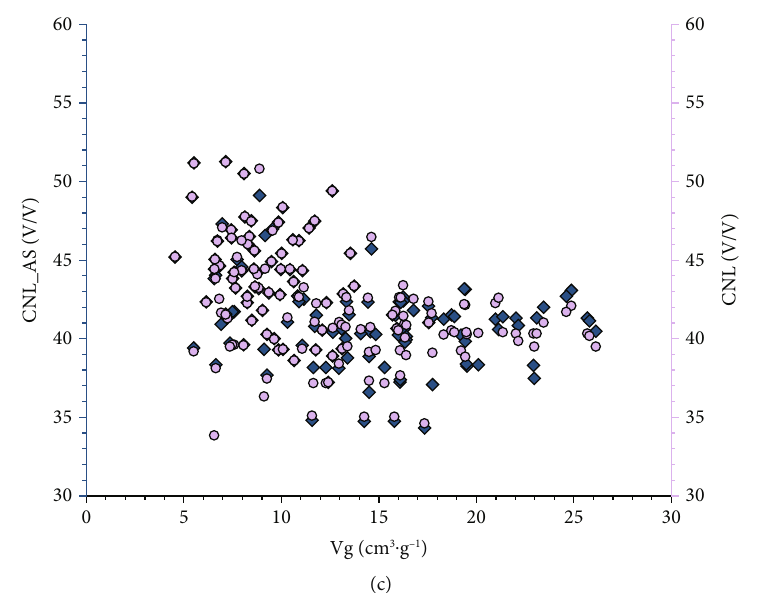
Figure 5: Standardized comparison of logging curves in porosity series: (a) AC curve, (b) DEN curve, and (c) CNL